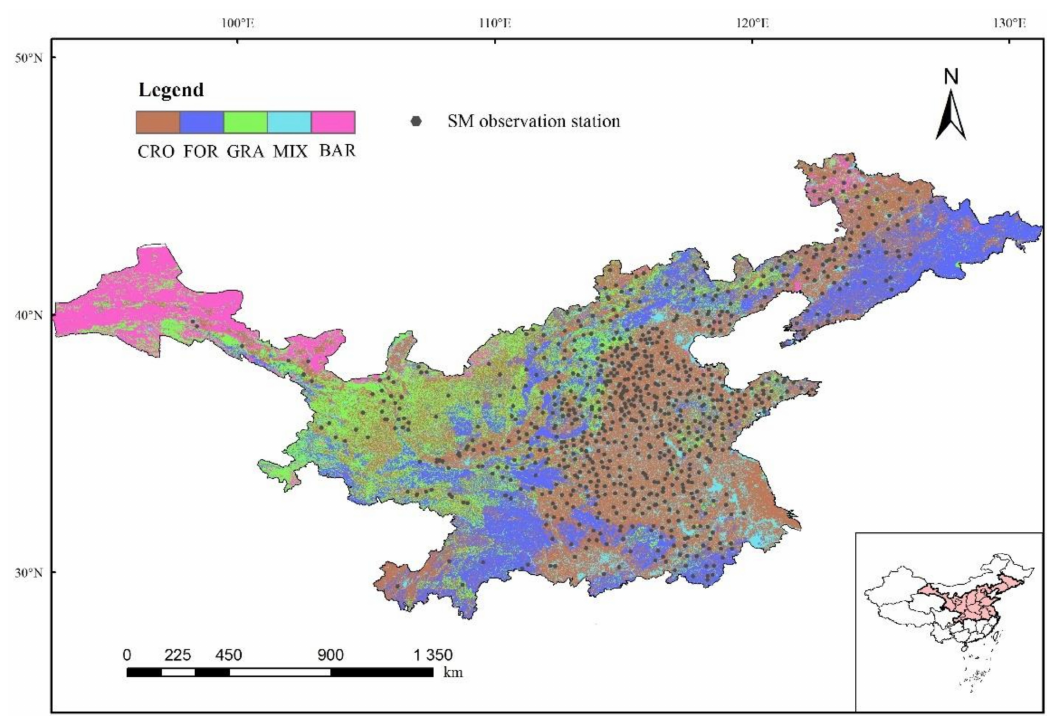
Figure 1. Locations of study area and in situ ground soil moisture (SM) monitoring network, together with distribution of land uses. Five land uses are involved here: Cropland (CRO), Forestland (FOR), Grassland (GRA), Mixed land (MIX) and Barren land